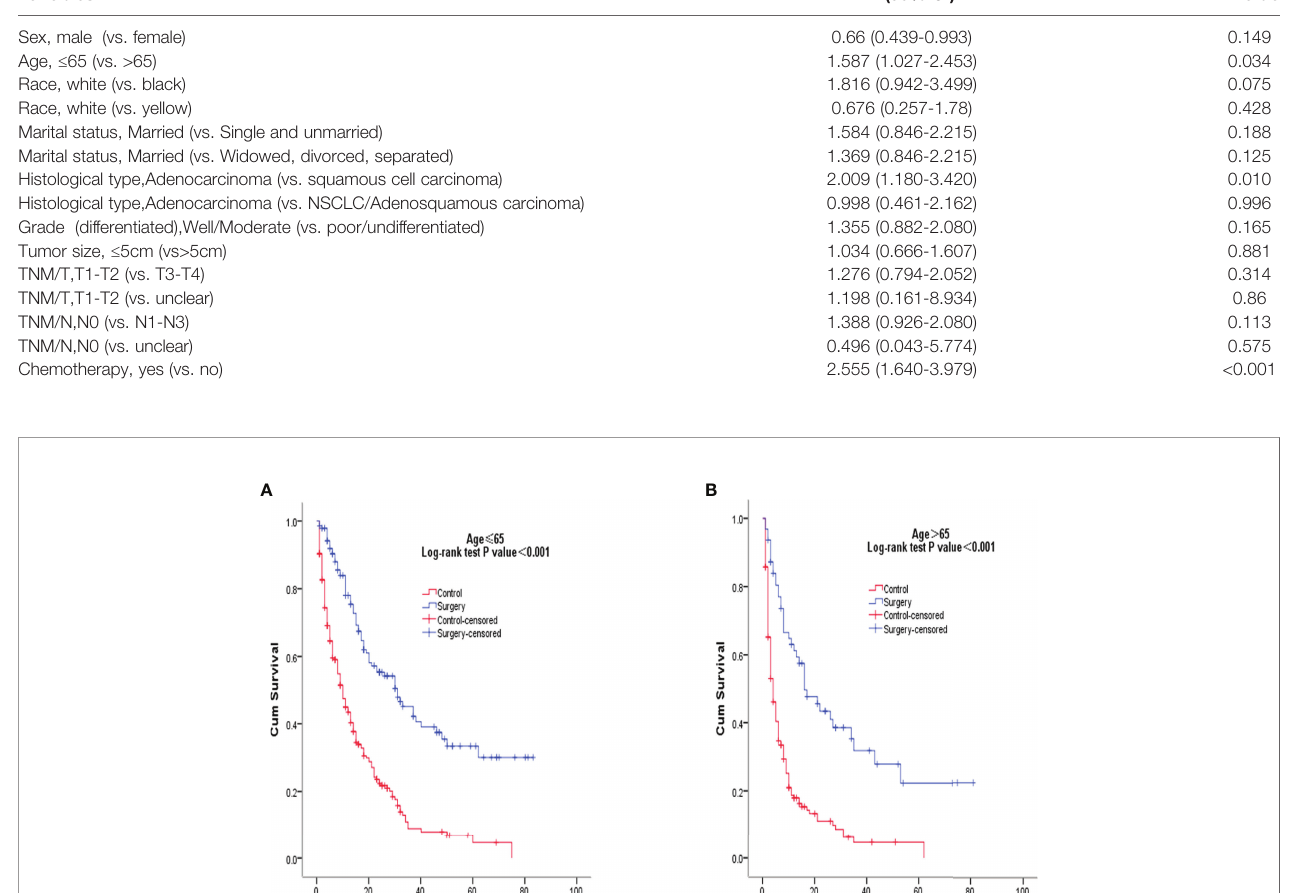
TABLE 4 | Multivariate analysis of predictors of survival among patients with surgery patients. Variables